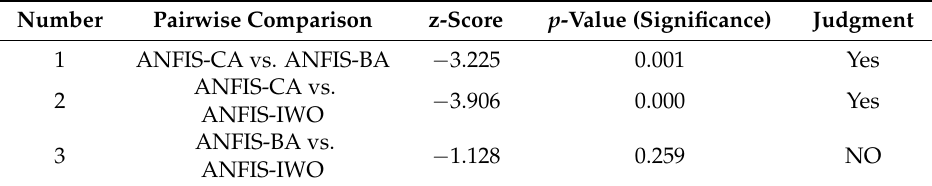
Table 3. Results of Wilcoxon signed-rank test